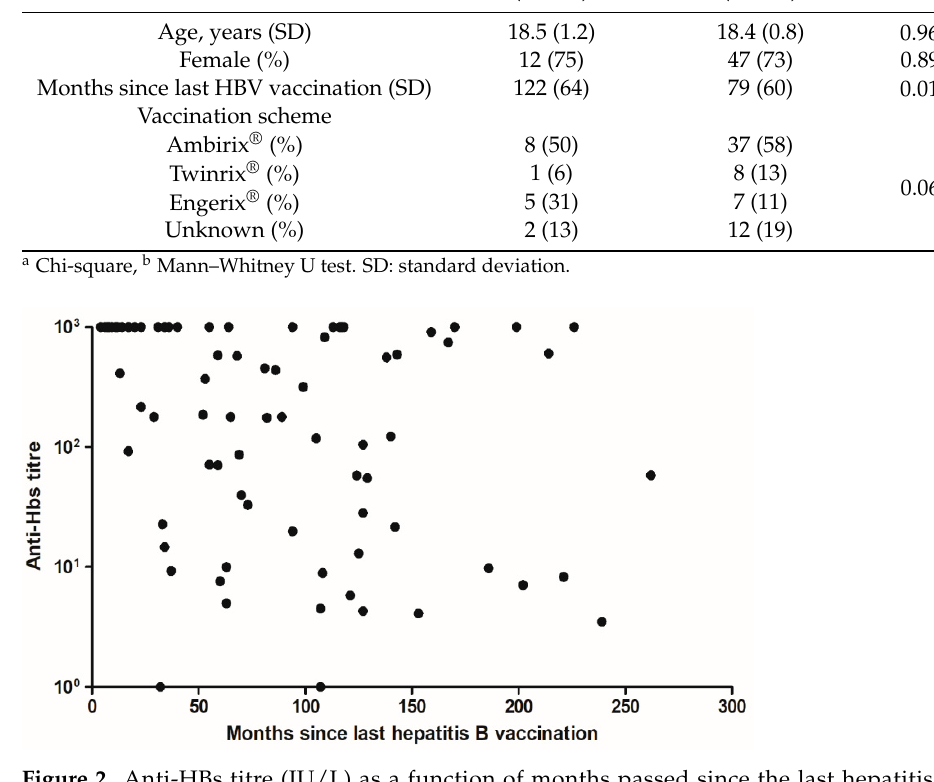
Figure 2. Anti-HBs titre (IU/L) as a function of months passed since the last hepatitis B vaccination. Minimum value of anti-HBs titre is ≤ 1.0 whereas the maximum value is ≥ 1000. An anti-HBs titre > 10.0 IU/L is considered protective.